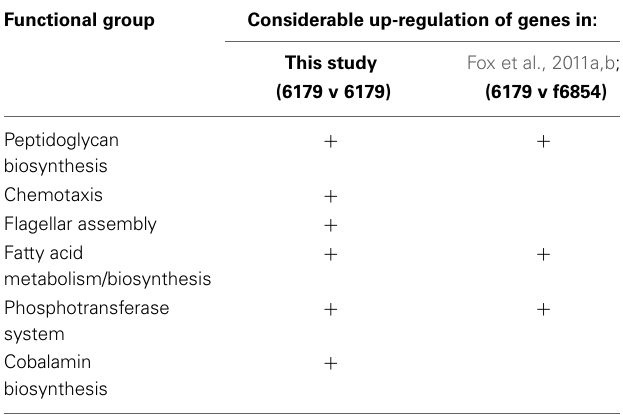
Table 1 | Functional Groups containing genes that were reported to be considerably up-regulated upon exposure of the bacterium to BZT: comparison of this study with that of Fox et al.